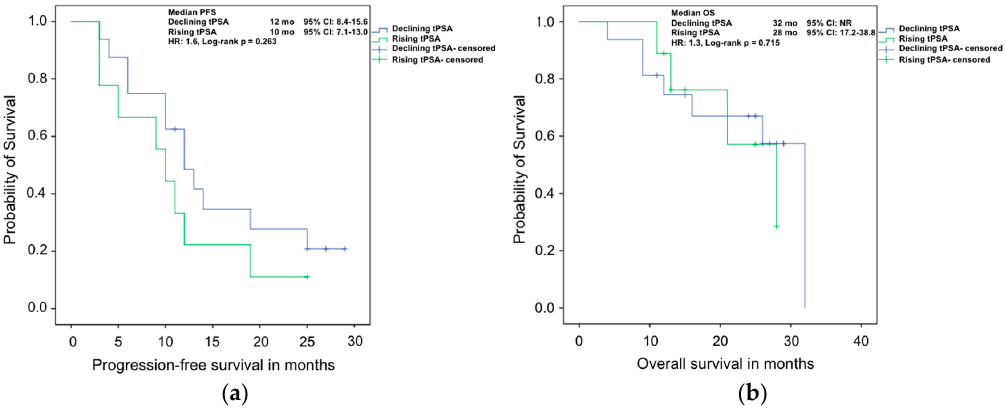
Figure 4. Kaplan–Meier analyses of ( a ) progression free survival; and ( b ) overall survival of mCRPC patients treated with Abiraterone with rising or declining tPSA values after 8–12 weeks of therapy.